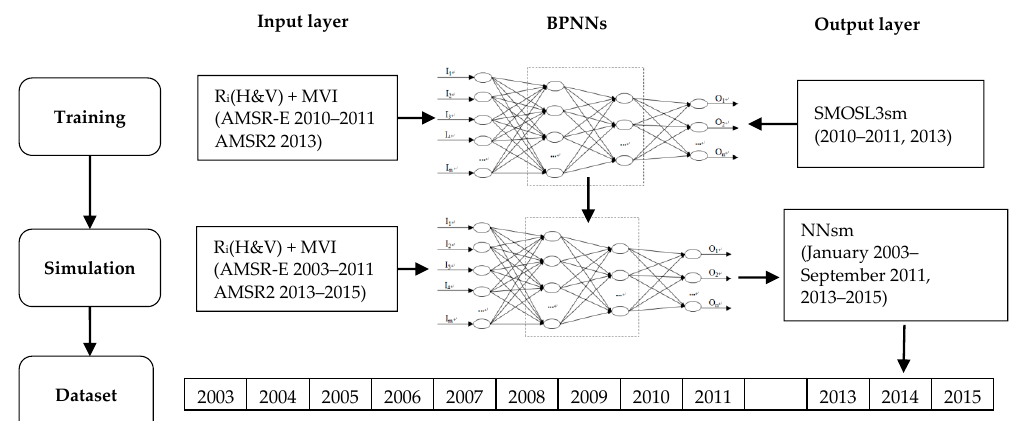
Figure 1. Flow chart of BPNN method.